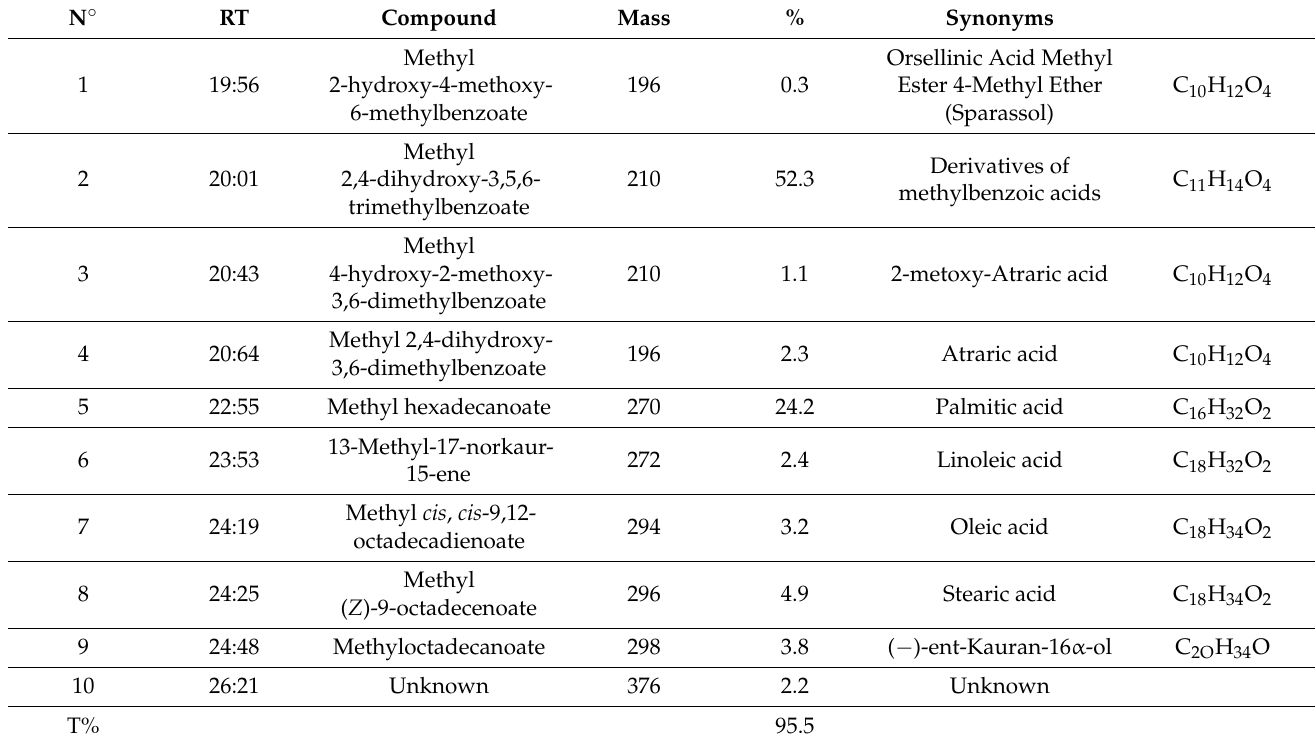
Table 1. Identification of metabolites in ME-hex of Physcia mediterranea by GC-MS analysis.